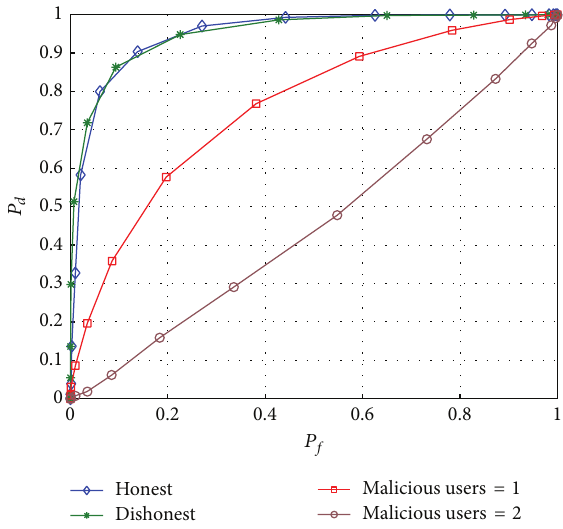
Figure 8: Performance comparison of honest, dishonest, and malicious users in scheme